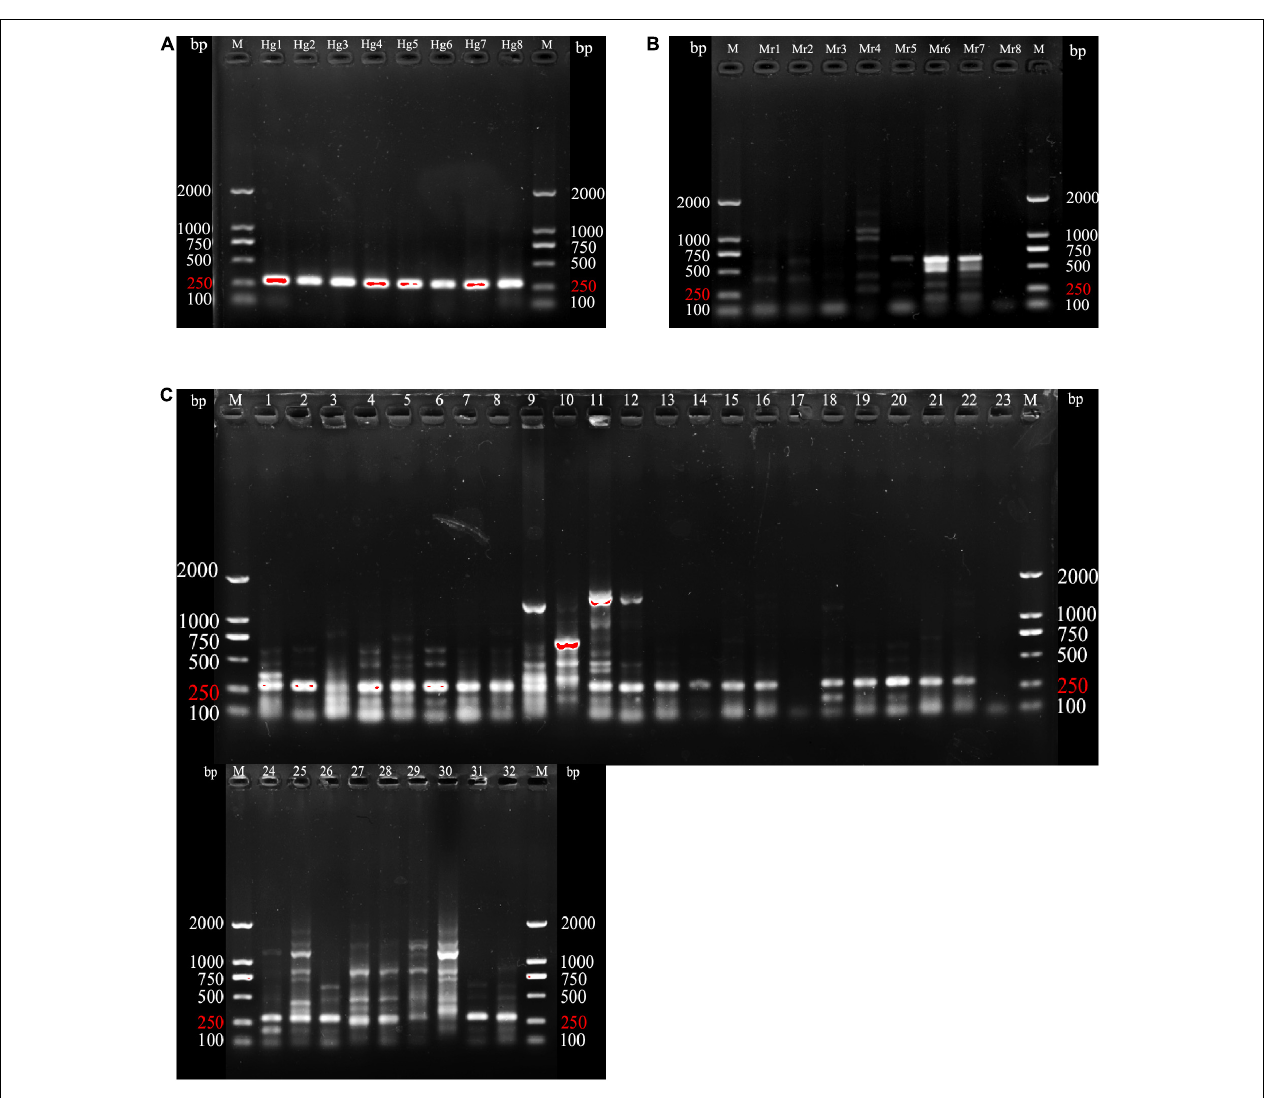
FIGURE 5 | PCR product agarose gel results for 8 genuine and 40 counterfeit samples using HGTY. (A) Agarose gel electrophoresis of 8 genuine samples (Hg1-Hg8). (B) Agarose gel electrophoresis of 8 M. reevesii samples (Mr1-Mr8) species-specific primers HGTY1. (C) Agarose gel electrophoresis of the species-specific primers HGTY1 with 32 counterfeit species samples (1–4: C. serpentina ; 5–6: C. galbinifrons ; 7–8: I. elongata ; 9–10: P. megacephalum ; 11–14: T. scripta ; 15–16: P. subrufa ; 17–18: C. amboinensis ; 19–20: M. sinensis ; 21–22: C. mouhotii ; 23–24: C. dentata ; 25–26: G. spengleri ; 27–28: M. mutica ; 29–30: M. annamensis ; 31–32: P. unifilis ). M, DNA